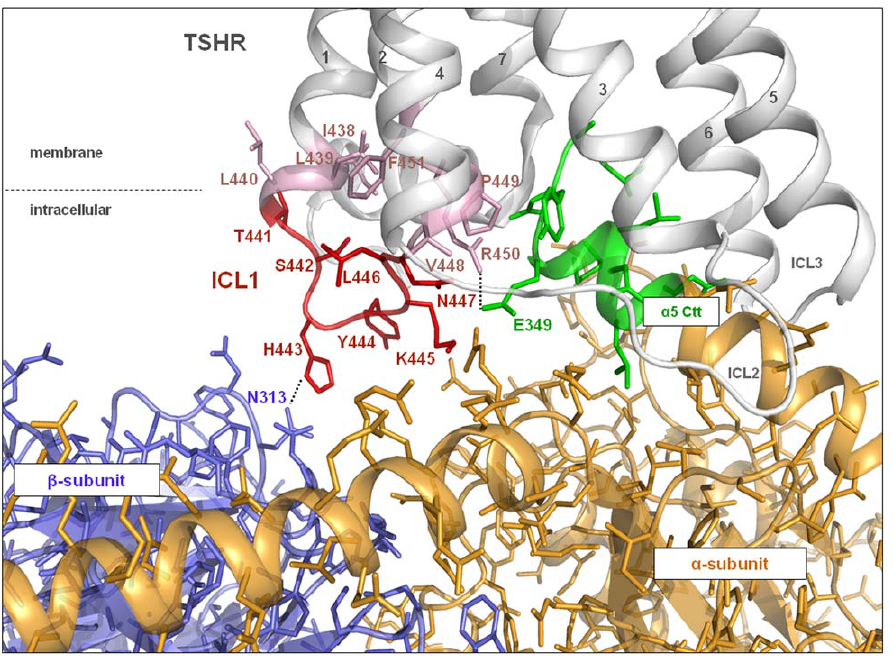
Figure 2. Homology model of the complex of TSHR/Gq with focus on the interface between ICL1 and Gq heterotrimer. The TSHR model suggests that in ICL1 (red) and in the transitions with the adjacent transmembrane helices (pale pink) the signaling sensitive amino acids (H443, R450) directly contact G bc (blue) and G a q (C-term a 5-helix: green), respectively. Dashed lines represent potential H-bonds. Others may indirectly affect Gq coupling (e.g. T441) via conformational changes of ICL1.